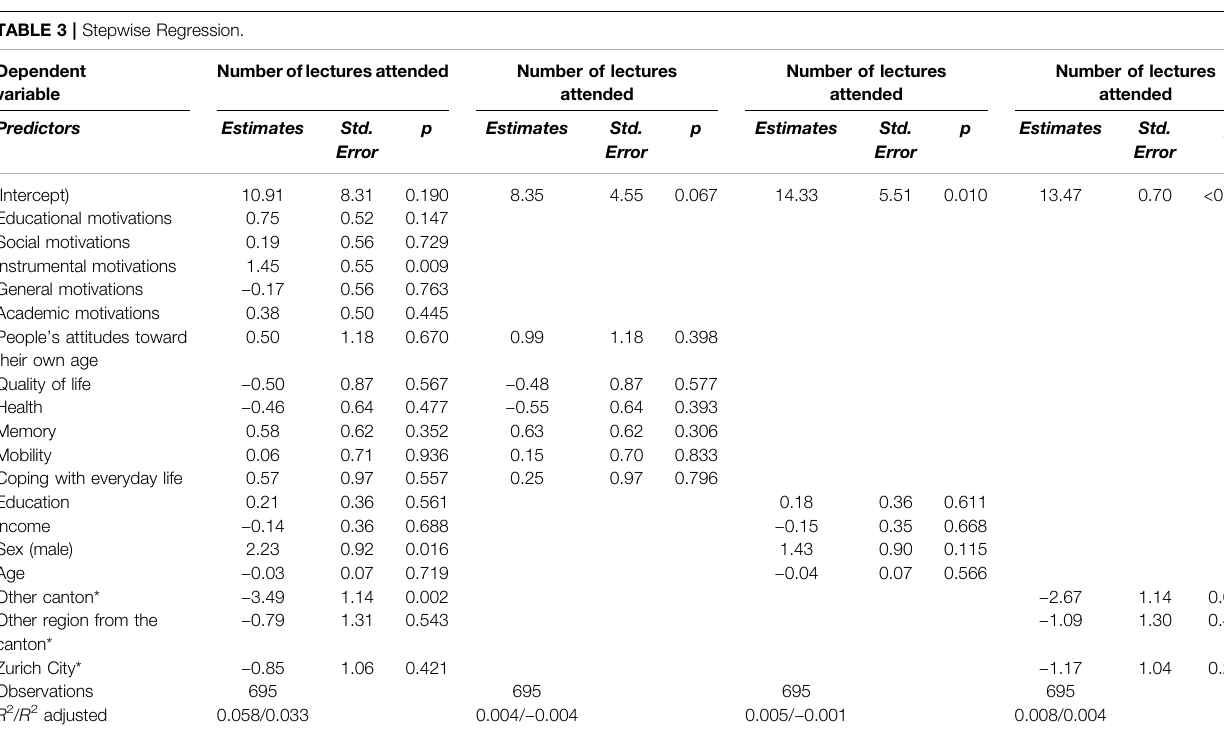
TABLE 3 | Stepwise